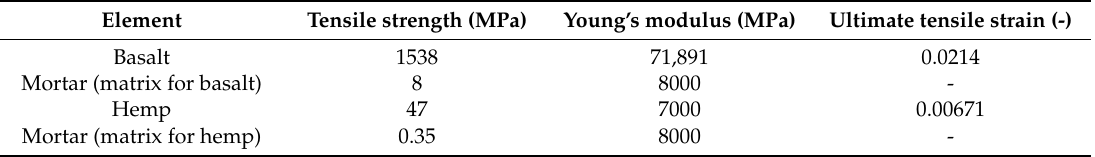
Figure 2. Stress-strain curves: ( a ) masonry material; ( b ) strengthening systems based on synthetic fiber (red lines) and based on natural fiber (blue lines). Table 2. Mechanical properties of strengthening systems.